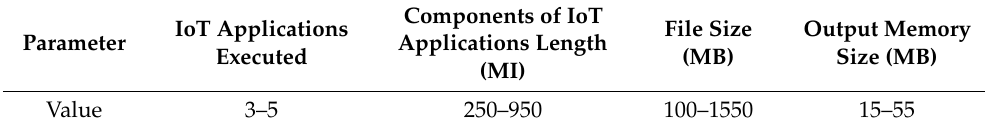
Table 3. Parameter settings of IoT application.